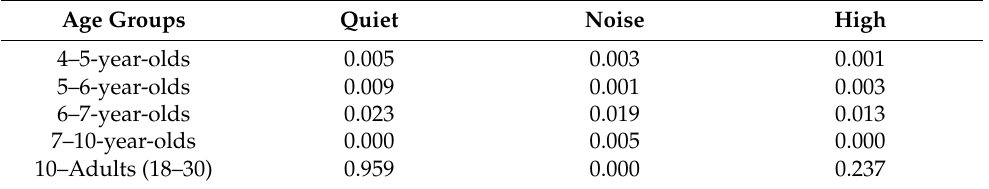
Table 3. Pairwise comparisons of AAST scores in quiet, noise and high across the different age groups.